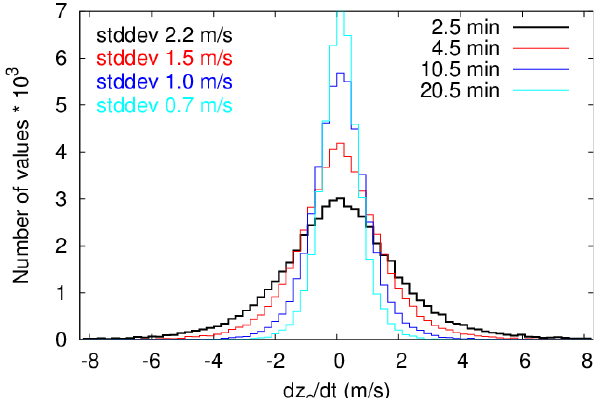
Fig. 6. Histogram of derivatives of all z c (t) of NWT and SET, 2008–2011. The derivative was estimated using different time win- dows, hinting at variability at different timescales. The hours of data used are between 364h (20.5min) and 451h (2.5min) due to boundary